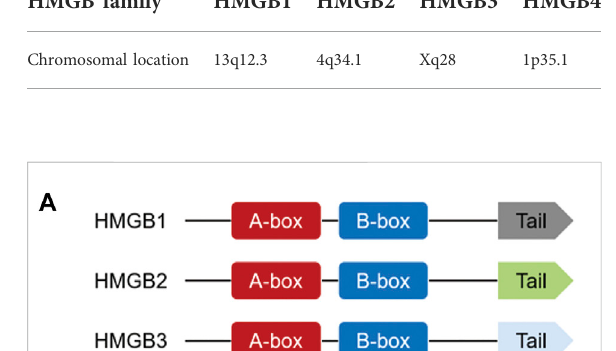
TABLE 1 The chromosomal locations of HMGB1, 2, 3, and 4.